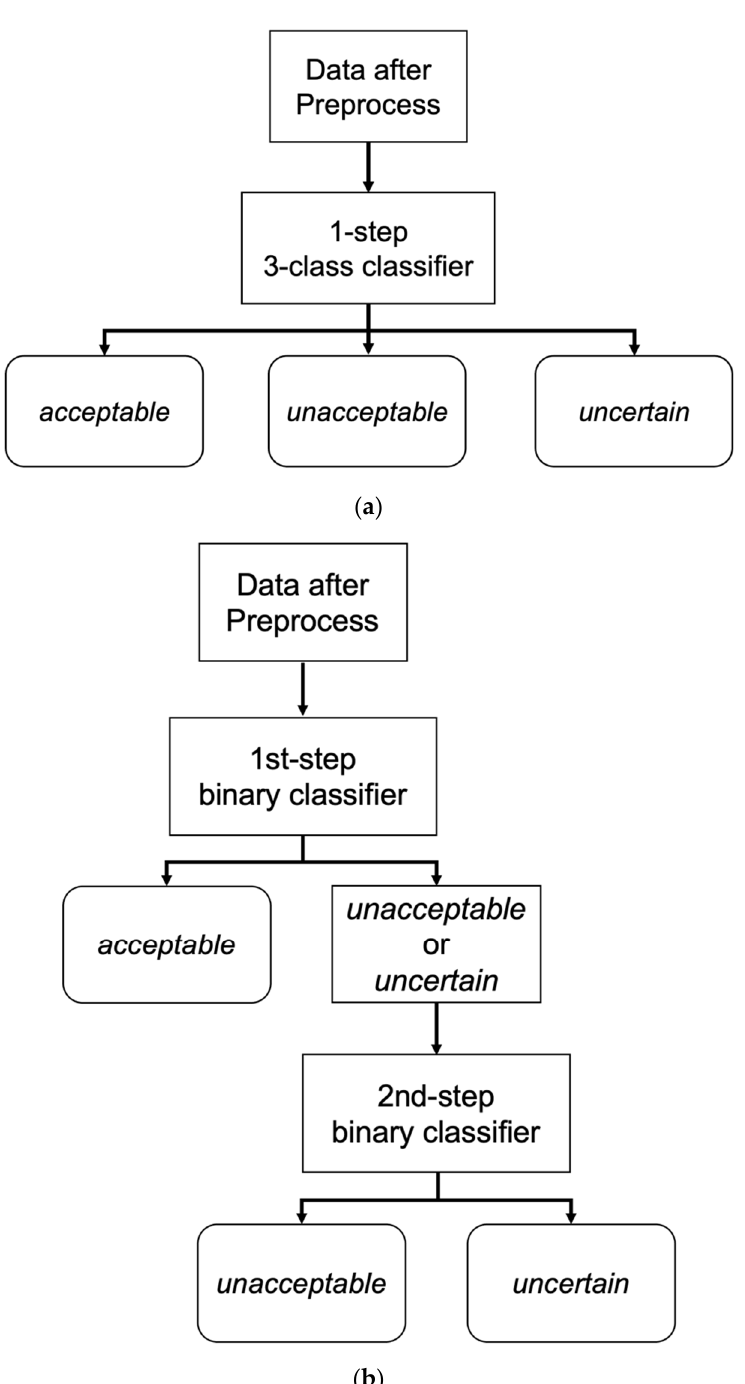
Figure 3. Classification logic of the: ( a ) one-step, 3-class approach; ( b ) two-step binary sequen- tial